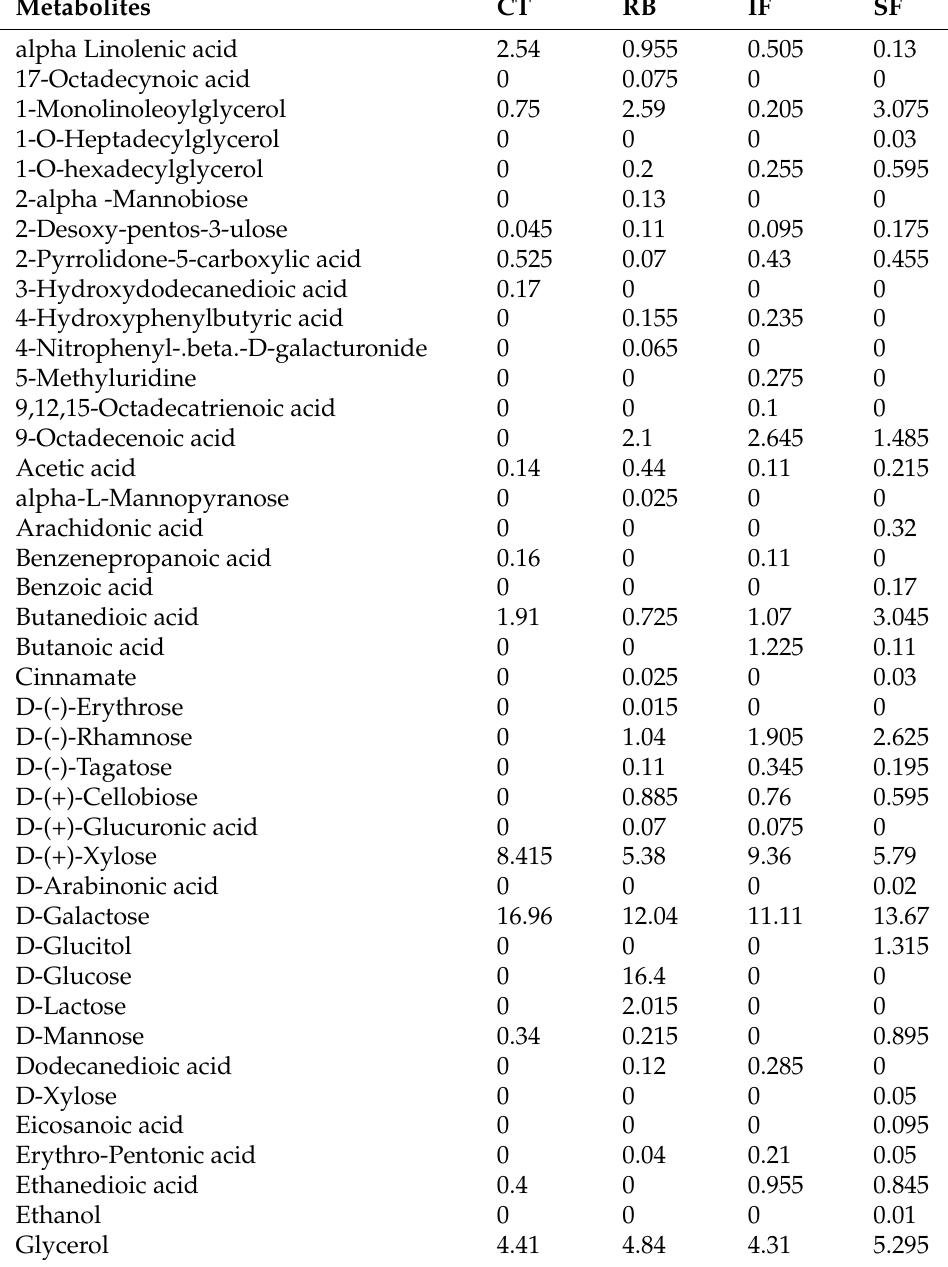
Table 3. List of mouse fecal metabolites (peak area percentage) after 30 days of treatment with different fractions of the beverage.(CT = control, RB = rice beverage, IF = insoluble fraction, and SF = soluble